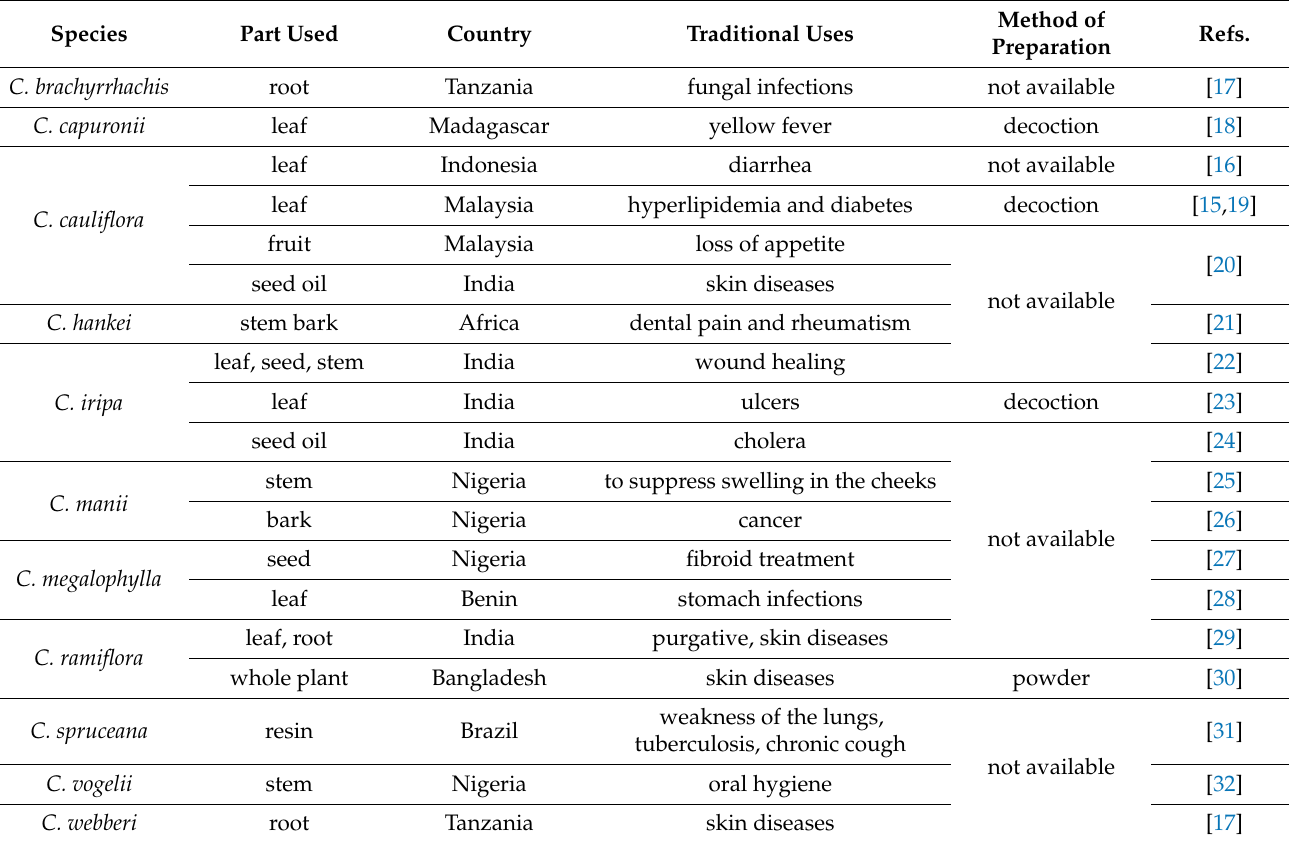
Table 2. Ethnomedicinal uses of the genus Cynometra.